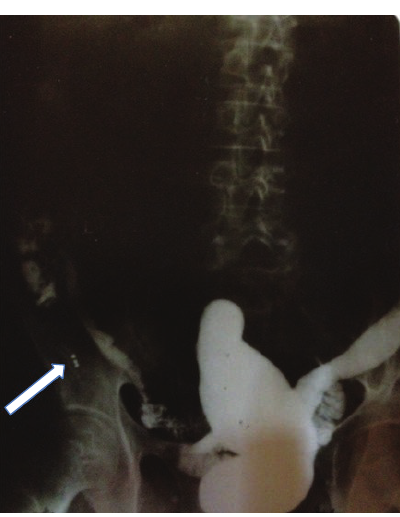
Figure 1: A barium enema shows opacities caused by three lead pellets within the appendix vermiformis (white arrow).